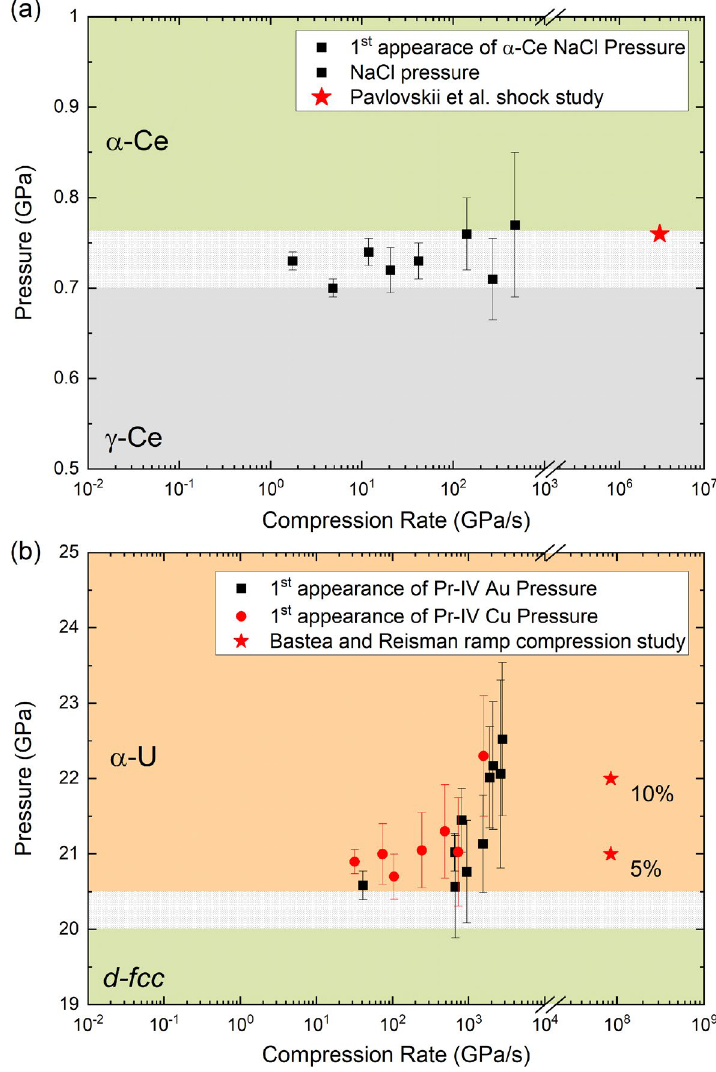
Figure 4. VC transition pressure as a function of compression rate for ( a ) Ce and ( b ) Pr. The dotted region is the reported range of the transition pressure as determined from static compression experiments found in